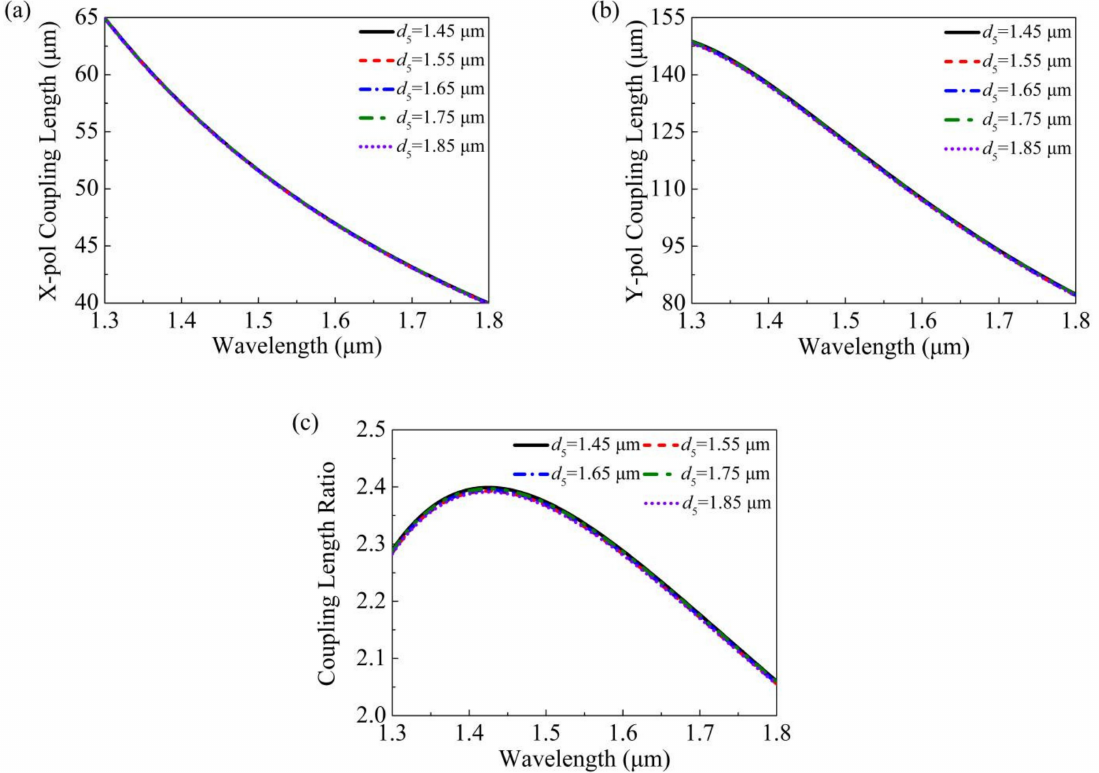
Figure 10. The change rules of the ( a ) CL X , ( b ) CL Y , and ( c ) CLR of the LC-DC-PCF with wavelengths for different d 5